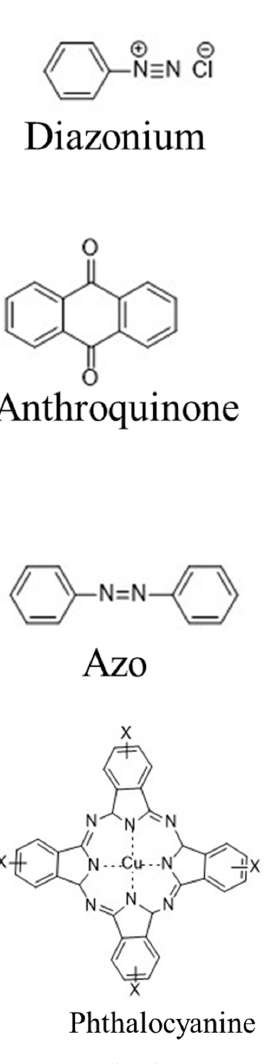
Figure 2. Molecular structure of some of the diverse classes of textile dyes. (Adapted with permission from reference [7], Copyright 2012 Elsevier). Table 1. Different types of dyes and their main applications. (Adapted from reference [8], Copyright 2018 Elsevier ). Type Water Solubility Applications Common Application Method Example Cosmetics, food, leather, modi- fied acrylics, nylon, paper, print- ing ink, silk and wool